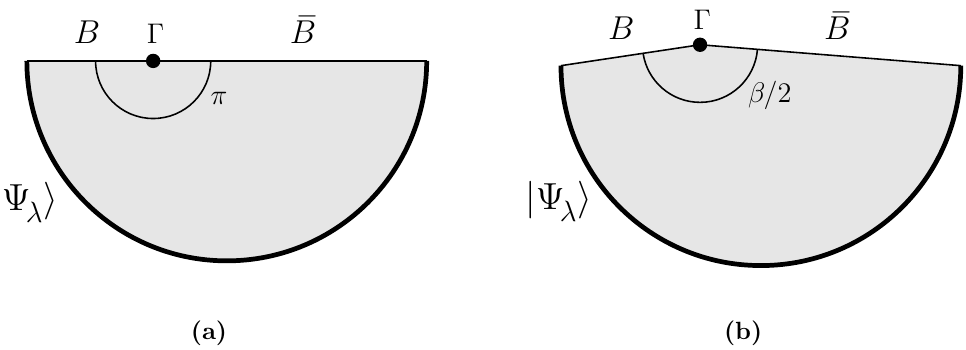
(cid:9) (cid:21) projected on a basis of (cid:12)eld-con(cid:12)gurations de(cid:12)ned j i